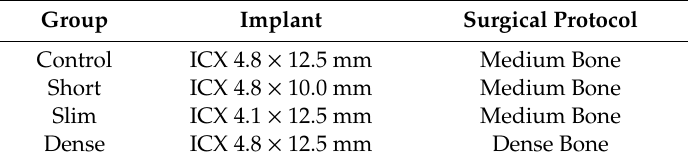
Table 1. Description of the four experimental groups